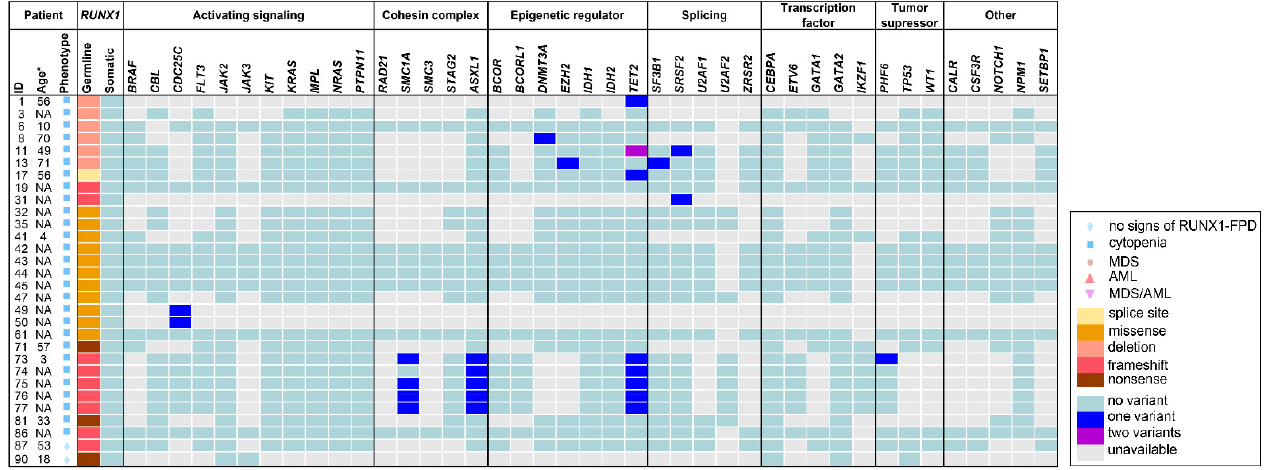
Figure 3. Frequently investigated and affected genes within the subgroup non-hematologic malig- nancy. Illustration of age, phenotype, type of RUNX1 germline variant and analyzed somatic variants for 30 non-HM cases. For references to the individual patients please refer to the supplementary